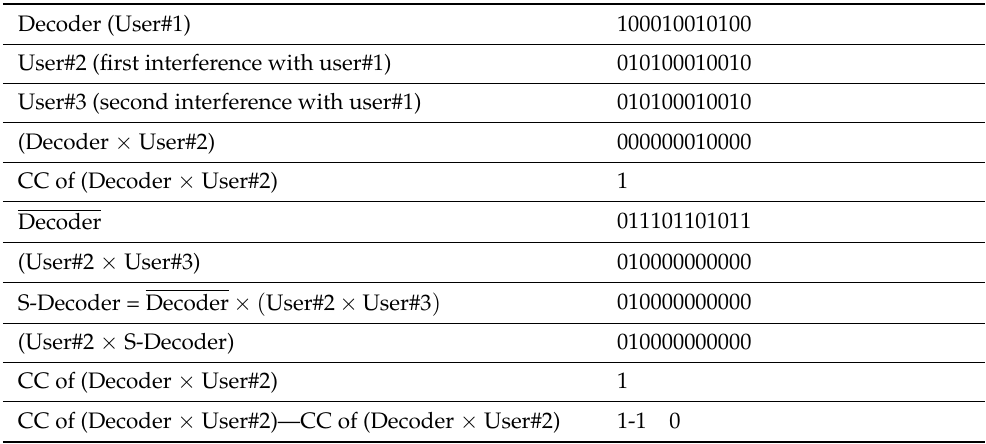
Table 4. Logical representation of interference cancellation.